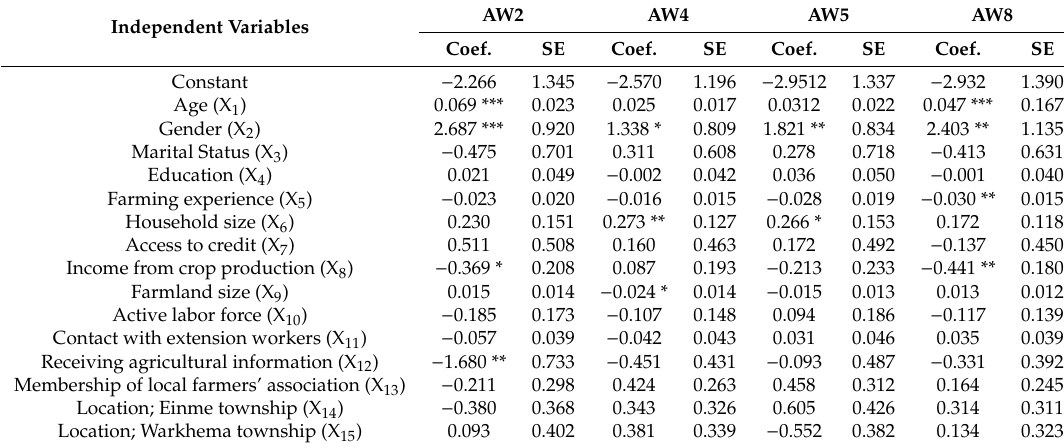
Table 11. The estimated coe ffi cients of the binary logit